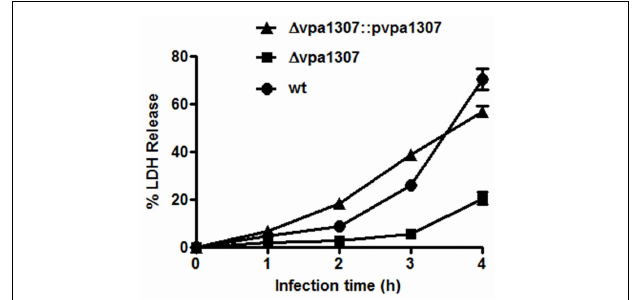
FIGURE 8 | Cytotoxic effect of vpa1037 on HeLa cells. HeLa cells were infected with V. parahaemolyticus at MOI of ∼ 50 cfu per cell. Supernatants